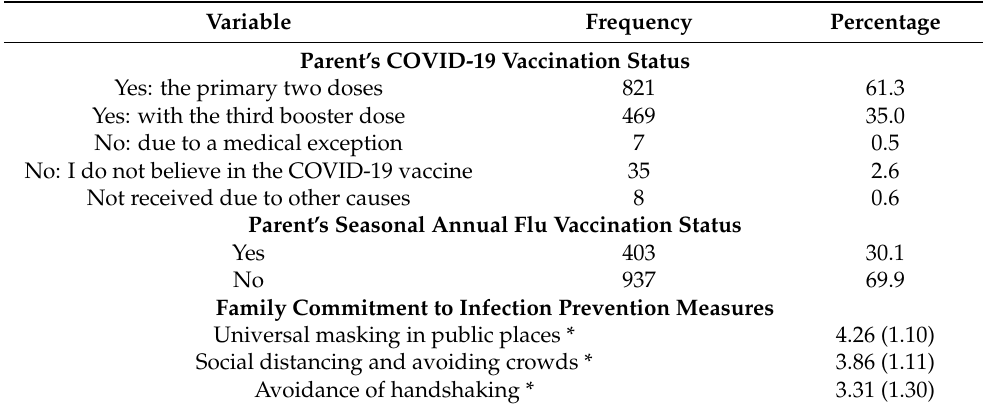
Table 2. Parents’ COVID-19 vaccination status and commitment to COVID-19 precautionary